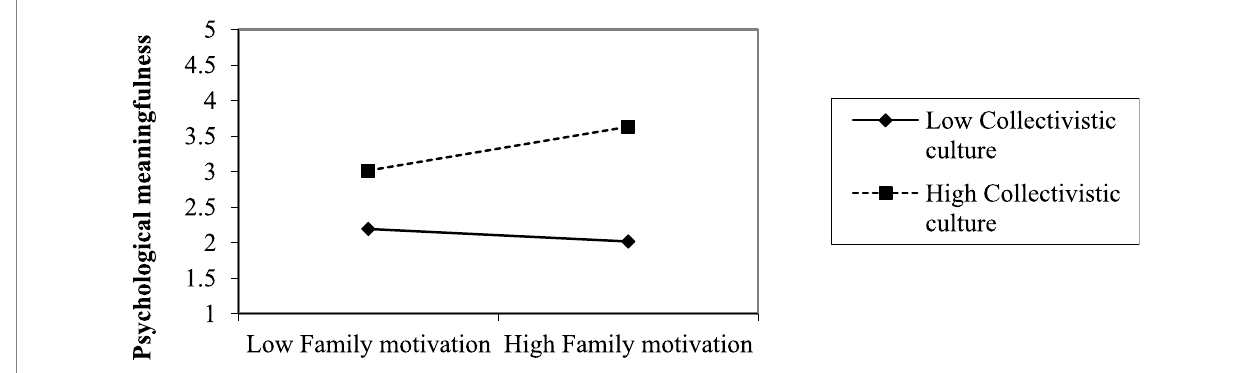
FIGURE 1 Moderating effect of collectivist culture on the relationship between family motivation and psychological meaningfulness.